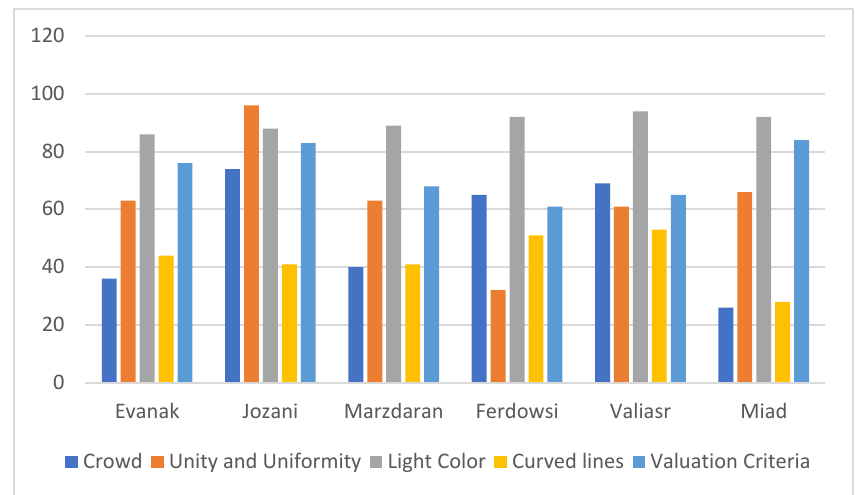
Chart 5. Comparison of streets in the evaluative criterion (Source: Authors).